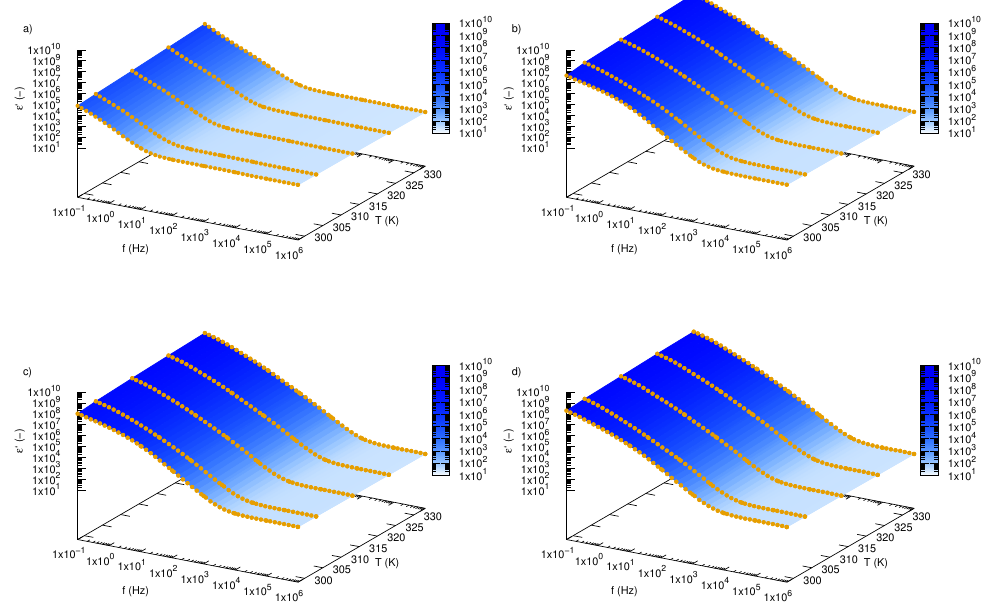
Figure 2. Real part of permittivity, ε ’, of silicon oxide lignin ethylene glycol nanofluids as function of frequency and temperature for ( a ) pure ethylene glycol, ( b ) 0.01 mass fraction, ( c ) 0.02 mass fraction, ( d ) 0.03 mass fraction.